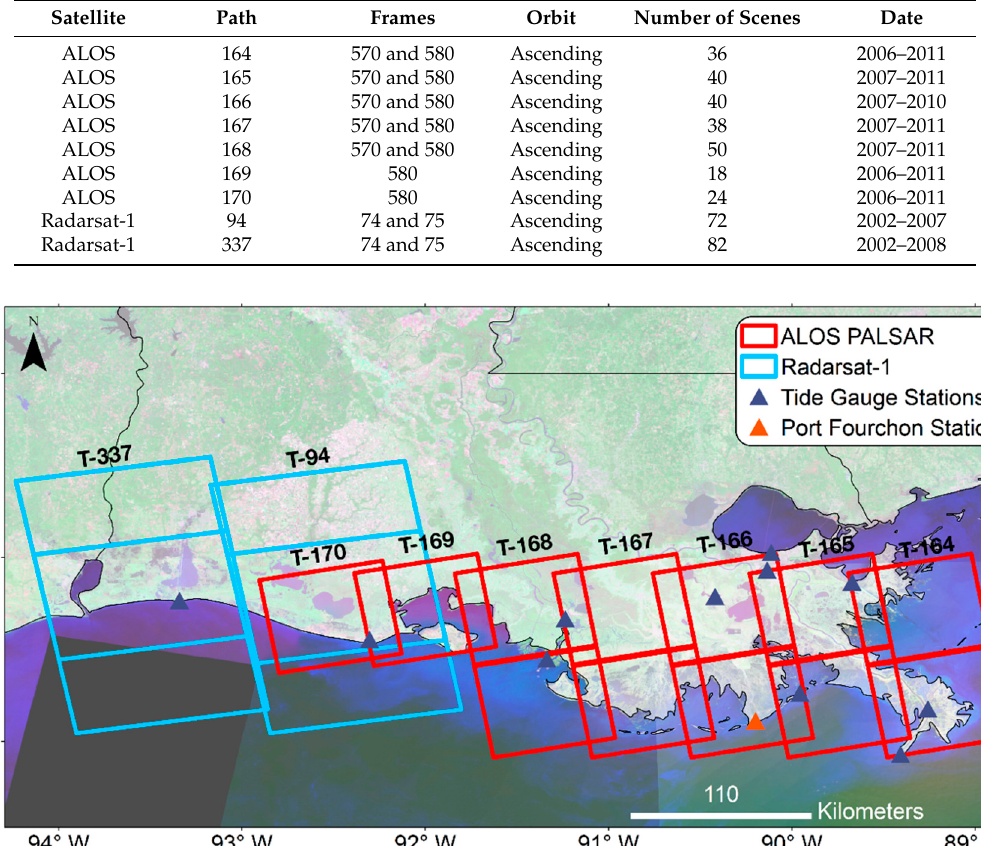
Figure 2. Location map of the Synthetic Aperture Radar (SAR) scenes and the available National Oceanic and Atmospheric Administration (NOAA) tide gauge stations for Louisiana (triangles). The orange triangle marks the location of the tide gauge used in this study.